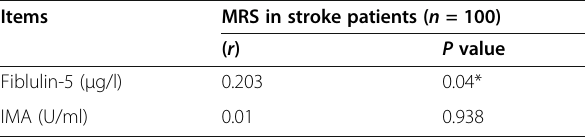
Table 10 Correlations between MRS with results of biomarkers at onset of stroke: